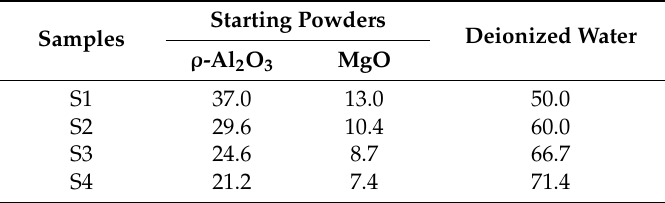
Table 1. Ratios of raw materials of the samples (wt